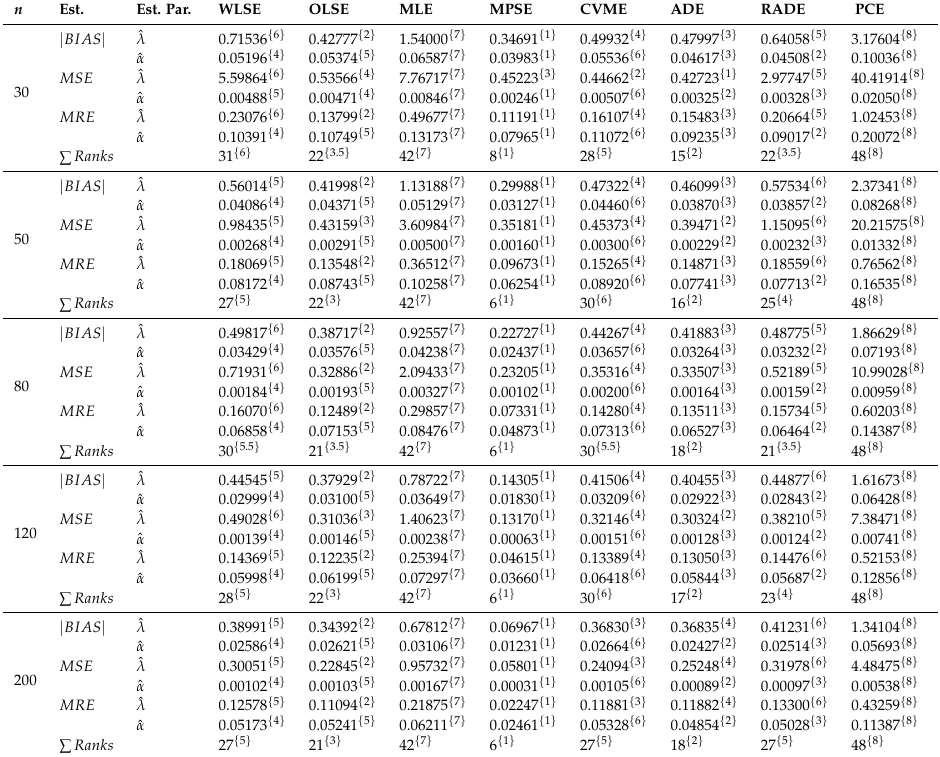
Table 6. Simulation results for φφφ = ( λ = 3.1, α = 0.5 ) (cid:124) .